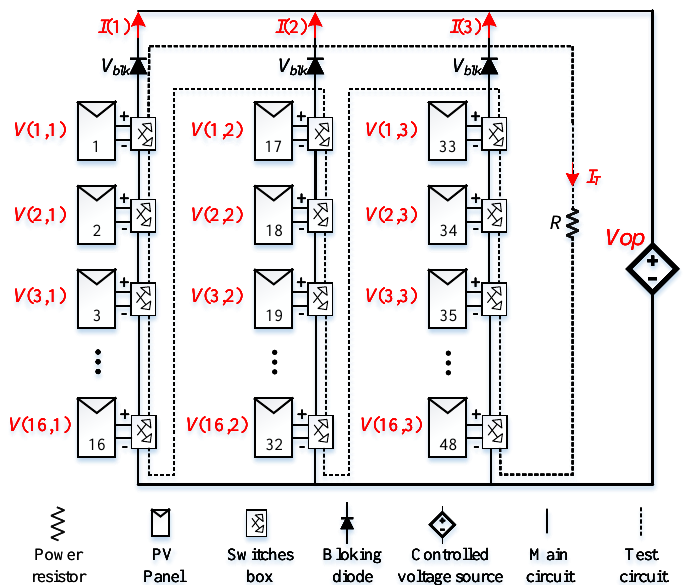
Figure 2. Model of the photovoltaic module implemented in Simulink. We use the mathematical matrix notation for locating modules and measurements in the solar array. This means that the physical location or the electrical measurements could be treated with the matrix form. In a PV array which has a size of m × n panels and n strings, the logic position p of each module could be easily defined using an ordered pair of variables ( i , j ) such as i ∈ [ 1, m ] for elements in the string, and j ∈ [ 1, n ] for strings in the array. In this way, the location is defined by ( i + m ( j − 1 )) ; for instance in the Figure 3, the measured voltage at panel 19 could be expressed as V ( 3, 2 ) .